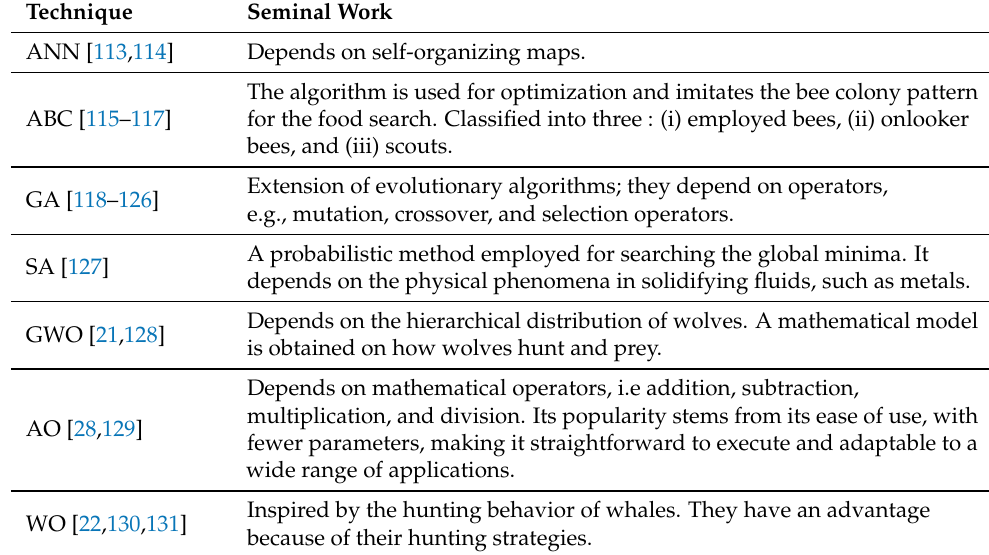
Table 3. Nature-inspired